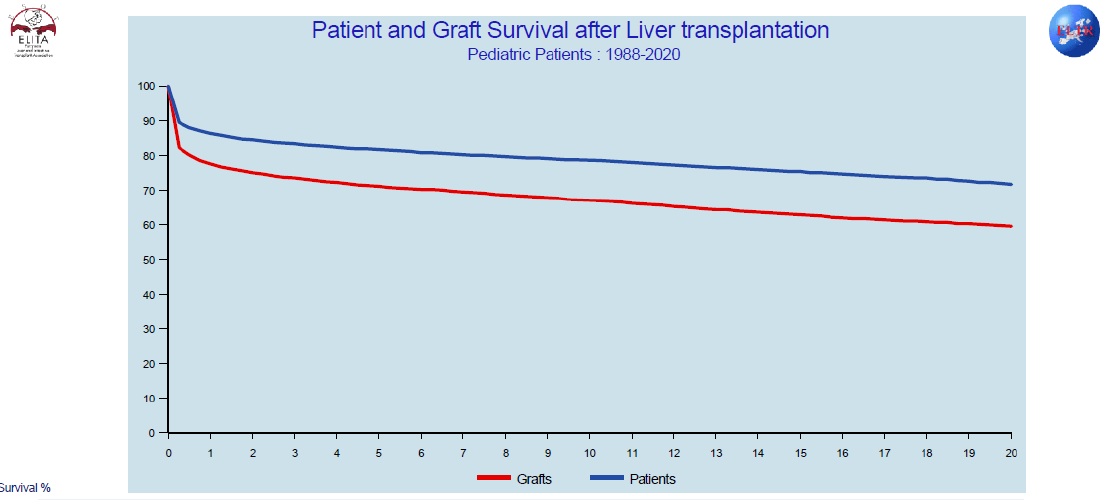
Figure 7. Overall patient and graft survival for pediatric LT included in the ELTR database between 1988 and 2020.